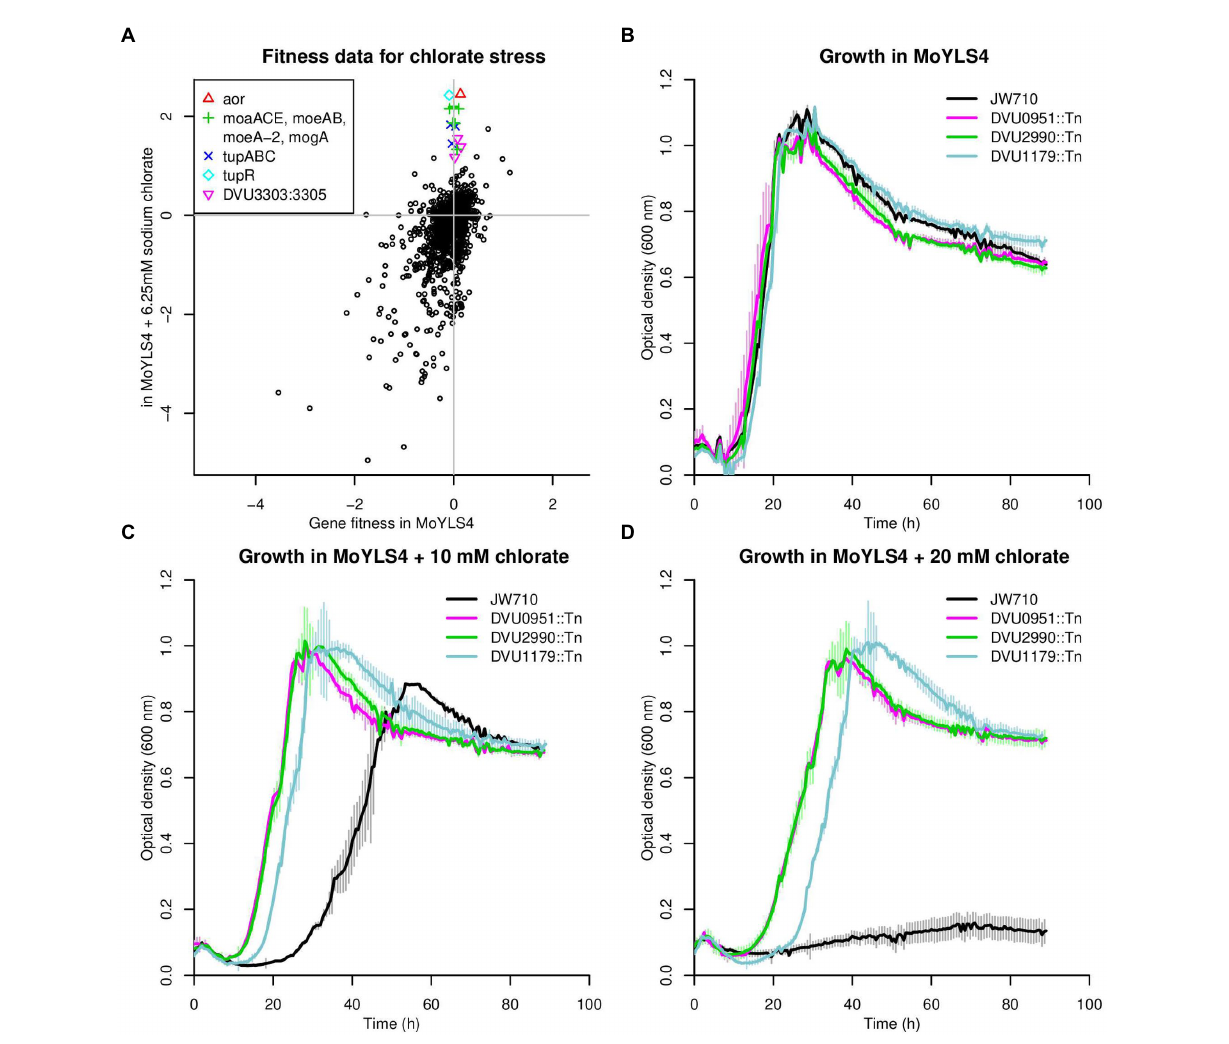
FIGURE 6 Loss of aldehyde oxidoreductase activity results in chlorate resistance. (A) Comparison of gene fitness values for growth in rich lactate-sulfate media or in media supplemented with 6.25 mM sodium chlorate. Each value is the average from three replicate experiments. (B–D) Growth of DvH JW710 and mutant strains of DVU0951 ( moeA ), DVU2990 (moeA-2) and DVU1179 ( aor ) in rich media with increasing concentrations of sodium chlorate. Each curve is the average of four replicates, and the thin vertical lines show one standard deviation on each side of the